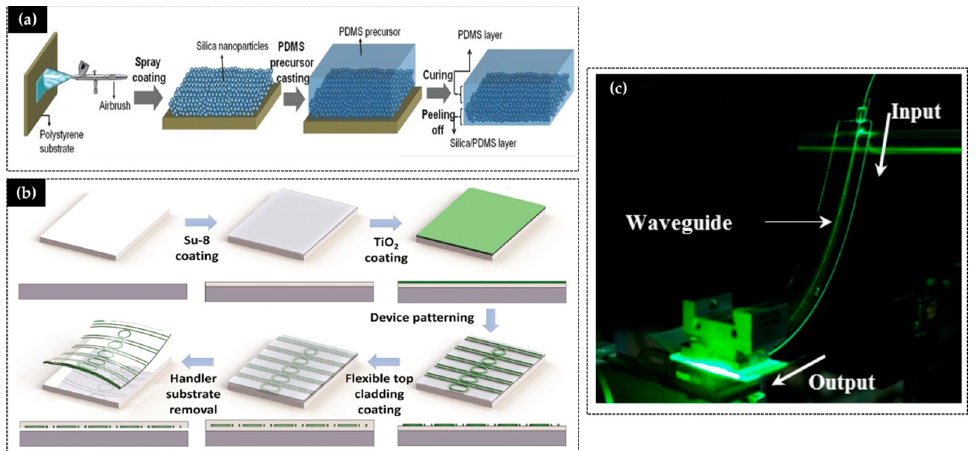
Figure 7. Examples of flexible glass for photonics applications: ( a ) schematic fabrication of a smart window (reprinted from [131] © 2021 with permission from Wiley), ( b ) schematic of the fabrication and de-attachment process of healthcare device (available at [132] printed with permission CC BY 4.0), ( c ) waveguides of photonics for telecommunications application (reprinted from [133] © 2021 with permission from OSA).